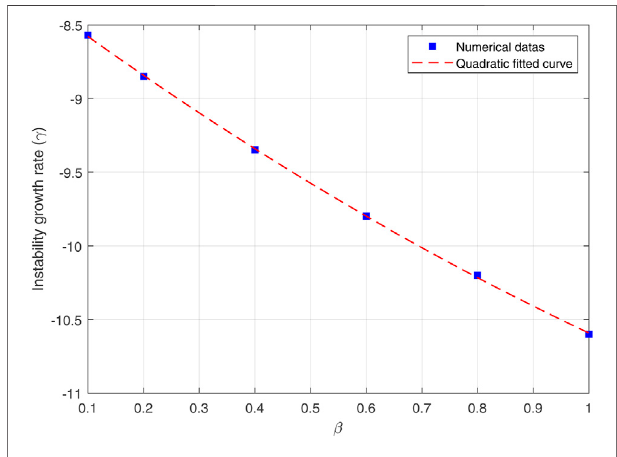
FIGURE 4 | Instability growth rate with β